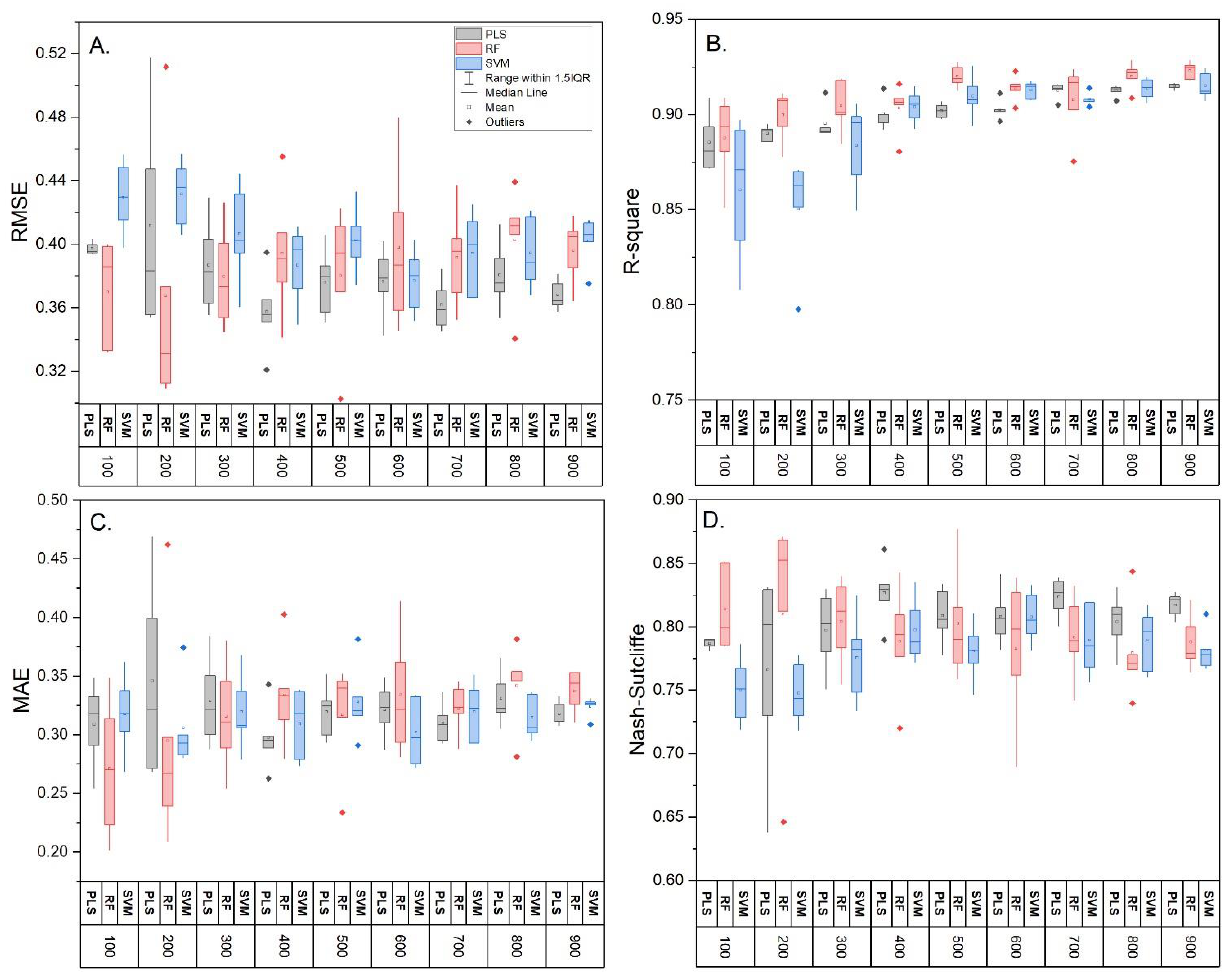
Figure 3. Box-plots graph showing the ability performance of partial least squares (PLS), random forest (RF) and support vector machine (SVM) models for predicting soil organic carbon (SOC) content using various calibration sampling size (100 – 900 samples). Each boxplot represents the results for the five random repetitions for each sample sizes. The performance metrics include ( A ) coefficient of determination root mean square error (RMSE), ( B ) coefficient of determination (R-square), ( C ) mean absolute error (MAE), and ( D ) Nash – Sutcliffe.